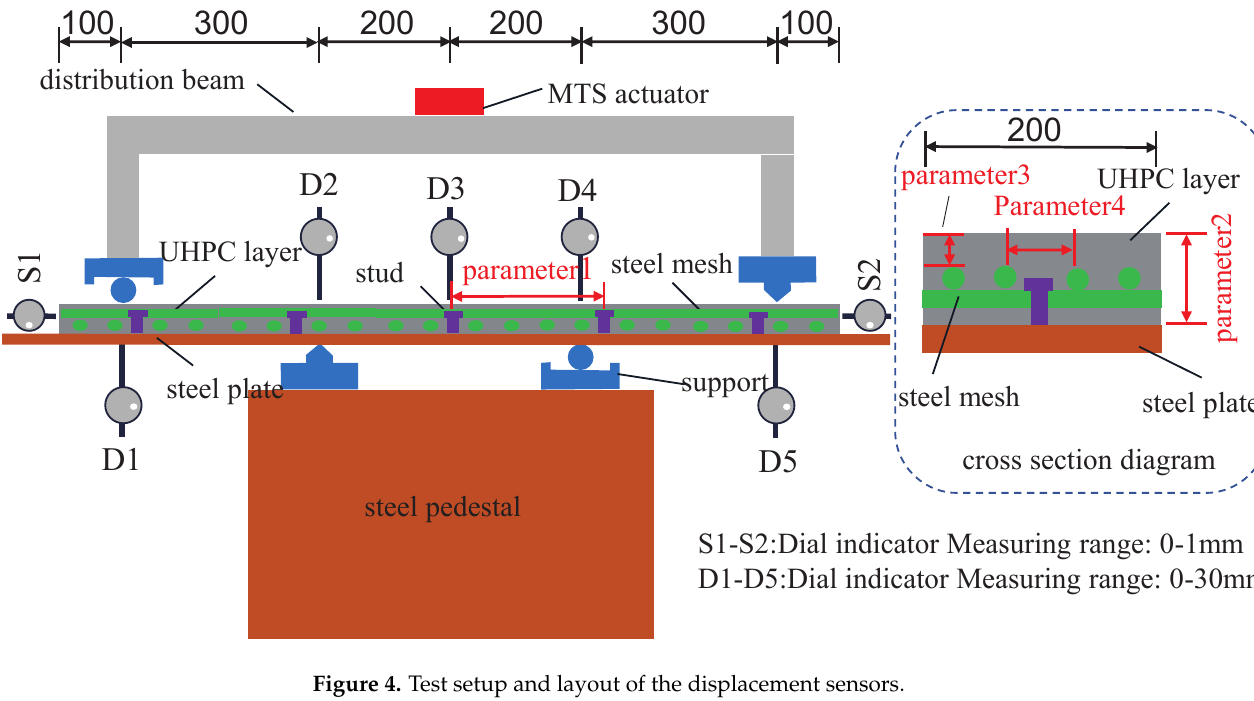
Figure 4. Test setup and layout of the displacement